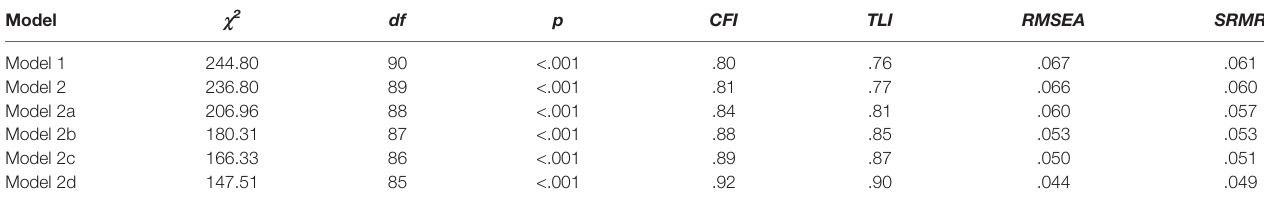
TABLE 2 | Fit indices for Con fi rmatory Factor Models of the IES-COVID19. Model